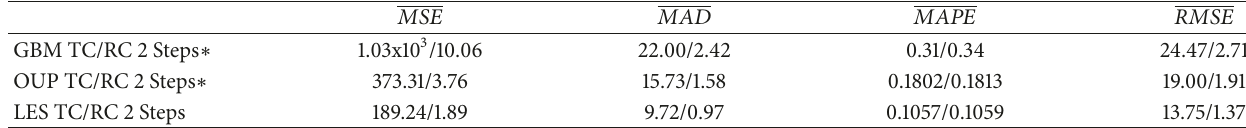
Table 16: TC/RC Best error measures for 2013–2014 forecasts after 1000 MC